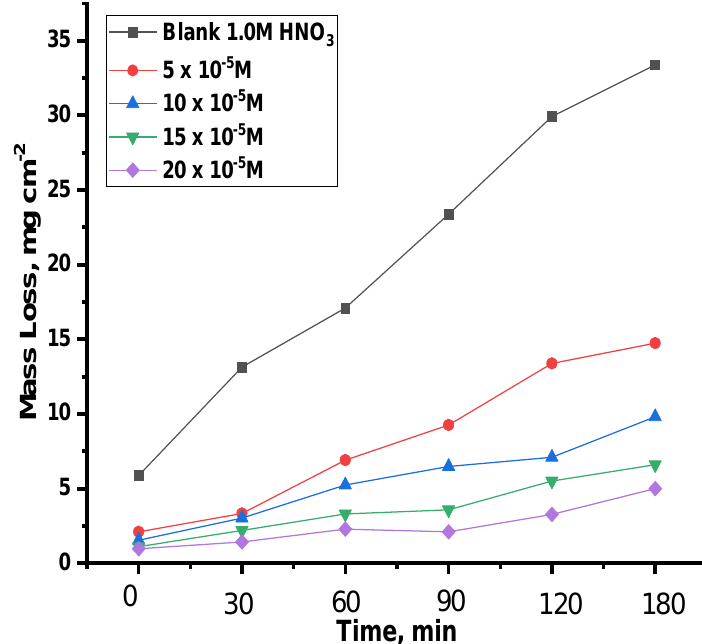
Figure 9. ACR-3 at 25 ◦ C and various immersion times in 1.0 M HNO 3 with and without